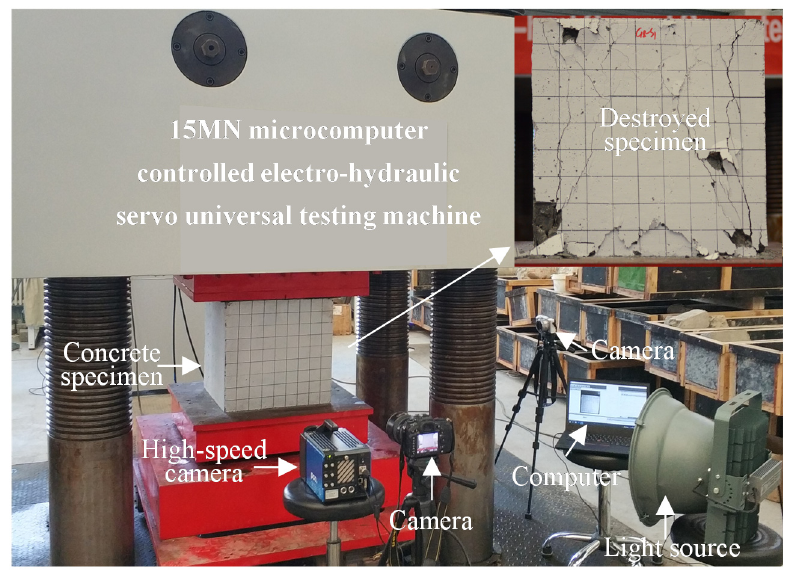
Figure 6. Compressive strength test processes of the four-grade concrete. Table 5. Compressive strength test of four-grade concrete with different CTF contents.